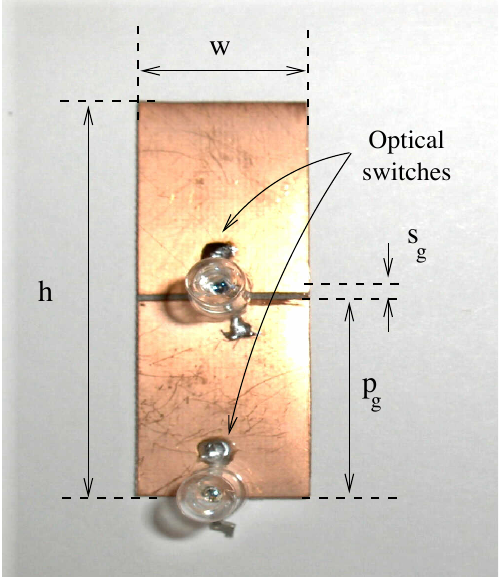
Figure 5. Photograph of a single parasitic element of the reconfigurable antenna, with optical switches assembled.